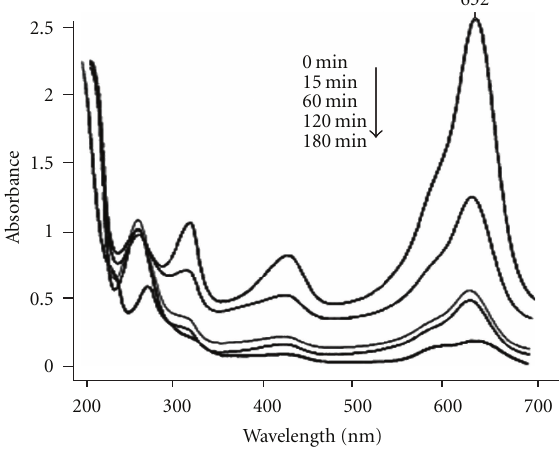
Figure 11: Decrease absorption spectra of MG (40mgL − 1 dye solution, pH = 5.2) in the presence of photocatalyst (1g L − 1 ) in time interval of 180